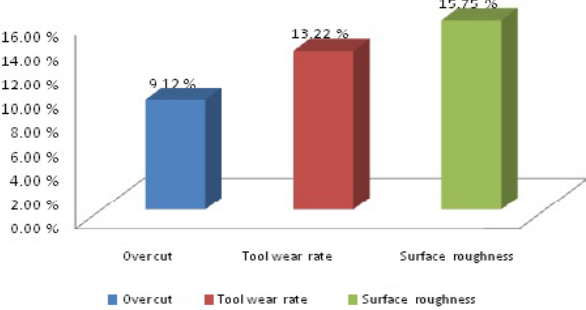
Figure 18. Percentage difference between traditional and non- traditional EDM.